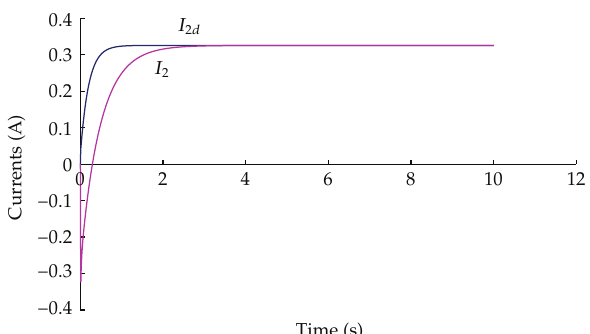
Figure 8: Tracking the desired current of the joint